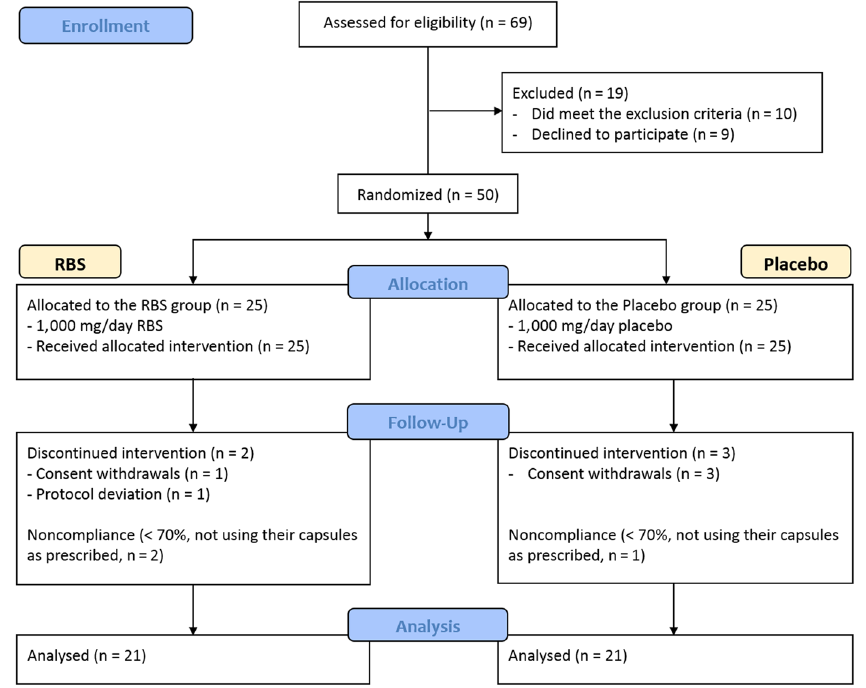
Figure 1. CONSORT flow chart-trial of study